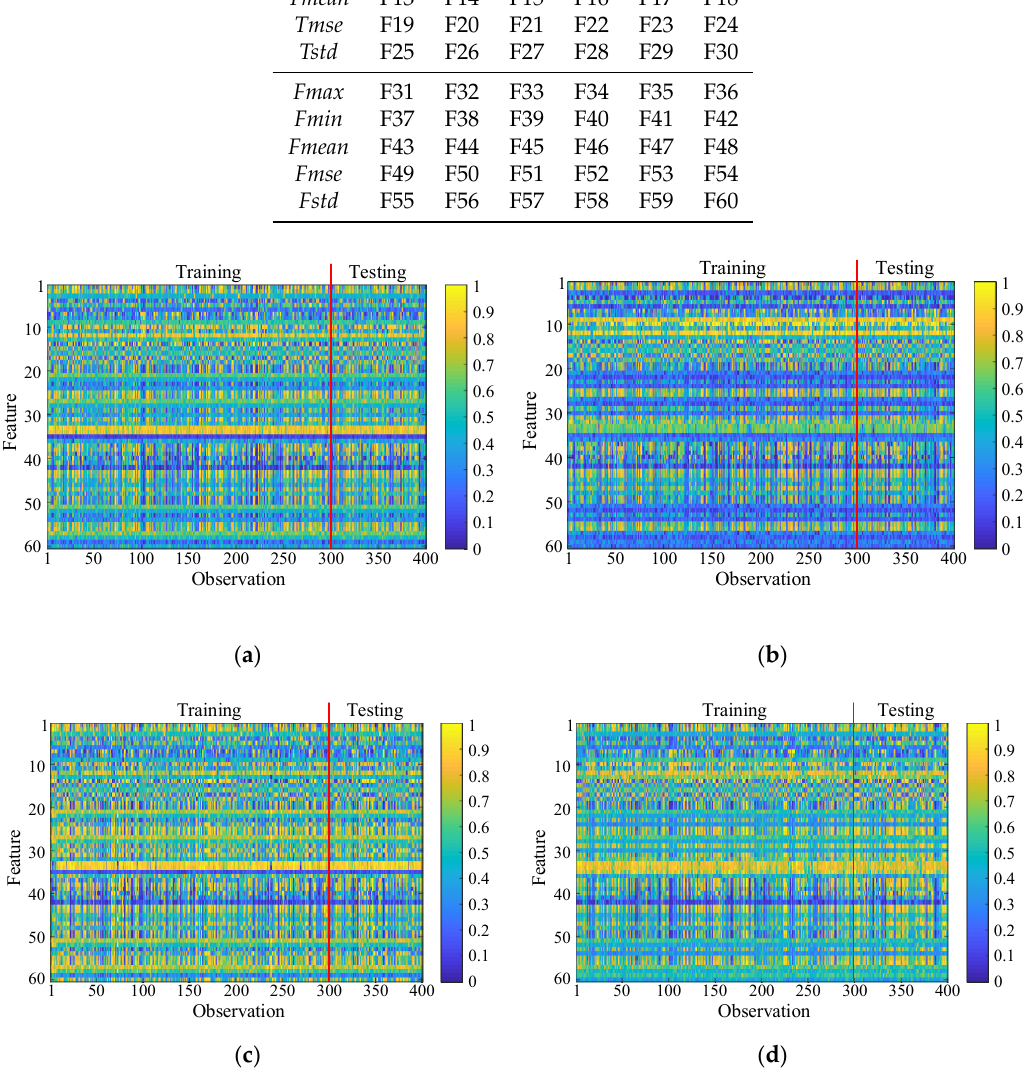
Figure 14. ( a ) Feature distribution of normal motor; ( b ) feature distribution of bearing failure; ( c ) feature distribution of stator winding failure ( d ) feature distribution of rotor failure.